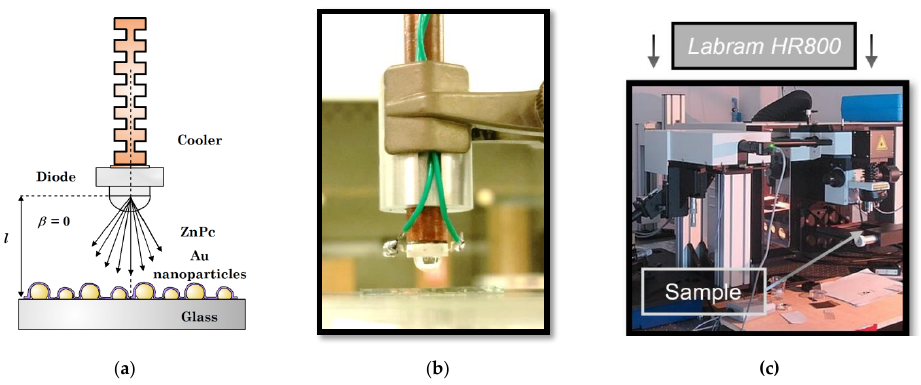
Figure 3. ( a ) Schematic illustration of the illumination geometry for the SERS study; ( b ) Physical realization of the illumination (photograph); ( c ) Labram HR800 spectrophotometer.